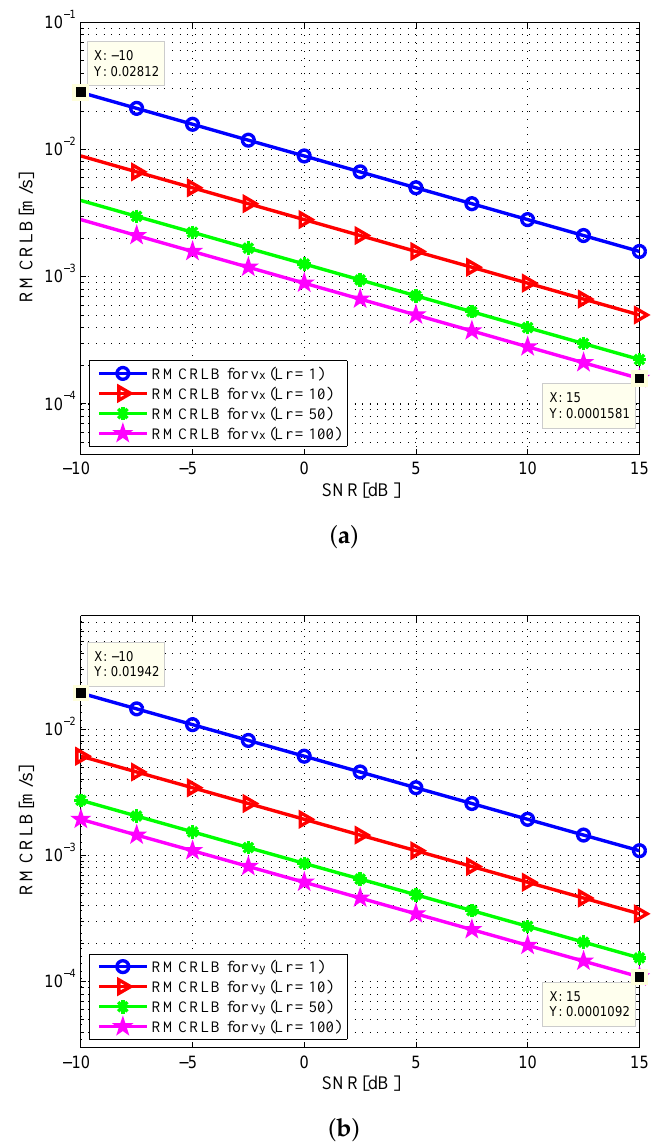
Figure 9. RMCRLB versus SNR in the target velocity dimensions with different L r when N = 1024 × 512 and T = 10 µ s: ( a ) x-velocity; ( b )